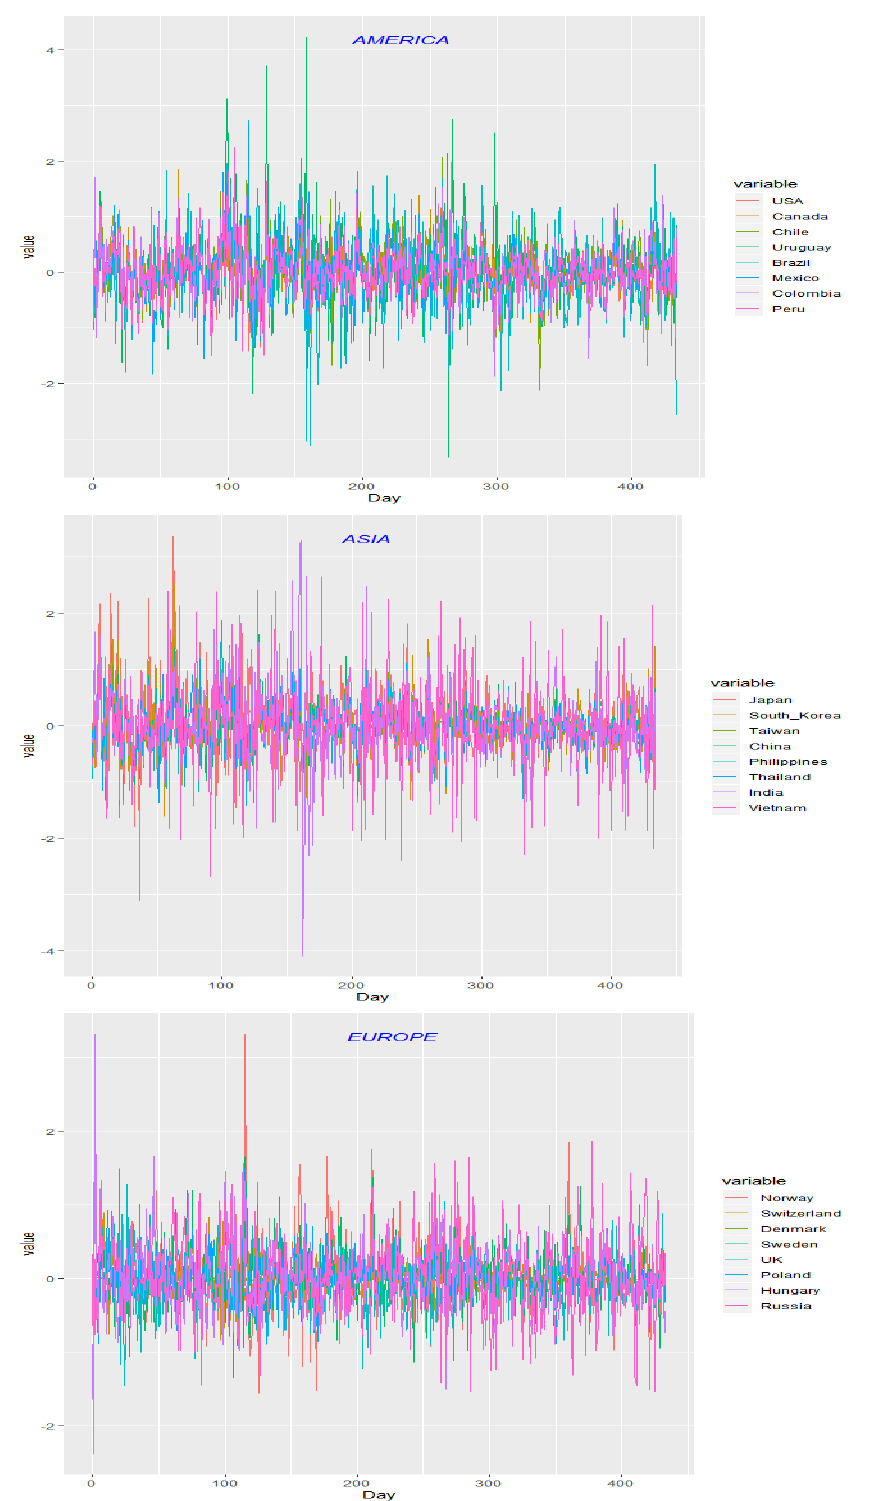
Figure 5. Twenty-four countries in America, Europe, and Asia (1/3/2013 to